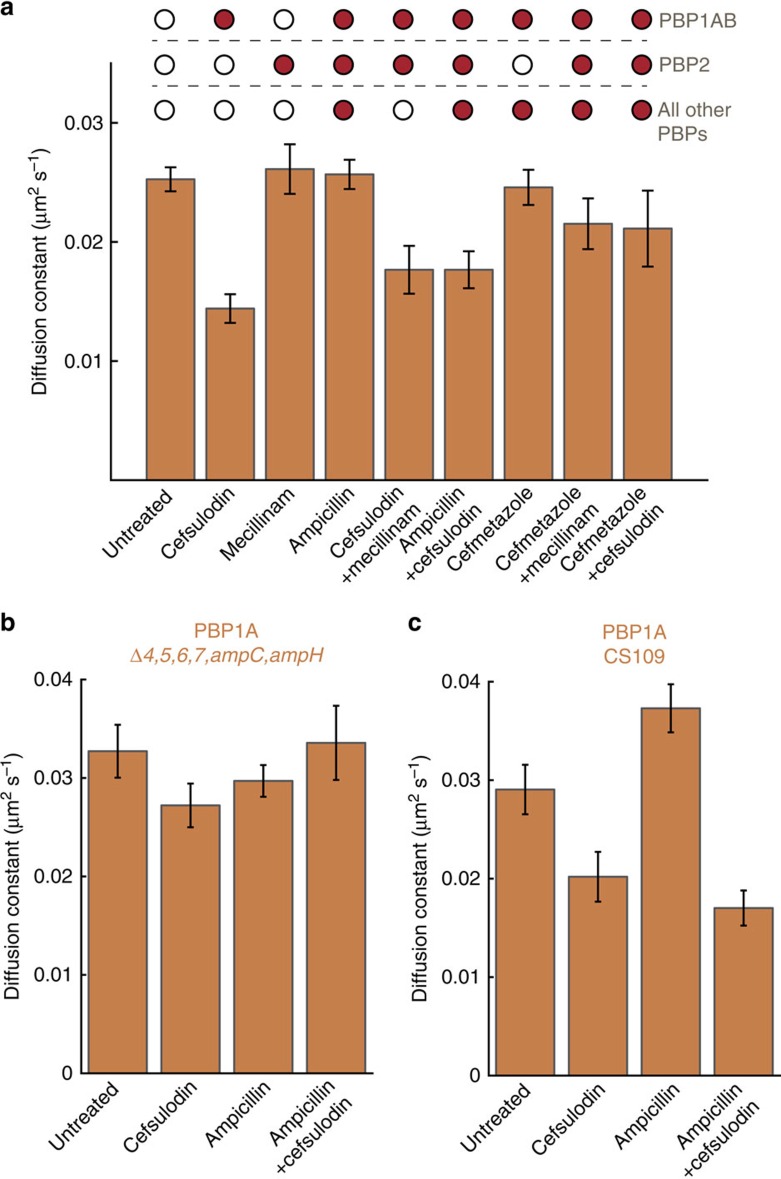
PBP1A diffusion depends on its enzymatic activity and interactions with other PBPs.(a) Apparent diffusion constants of PAmCherry-PBP1A molecules (TKL241) imaged on agarose pads containing β-lactam antibiotics (100 μg ml−1 each). The canonical targets for each antibiotic are indicated with filled red circles. (b) Apparent diffusion constants of PAmCherry-PBP1A molecules imaged in CS612, a strain containing multiple deletions for PBPs (CS109 ΔdacB/pbp4 ΔdacA/pbp5 ΔdacC/pbp6 ΔpbpG/pbp7 ΔampC ΔampH) on agarose pads containing various antibiotics. (c) Apparent diffusion constants of PAmCherry-PBP1A molecules imaged in the wild-type strain background CS109. Error bars indicate the s.d. of 1,000 bootstrap samples.